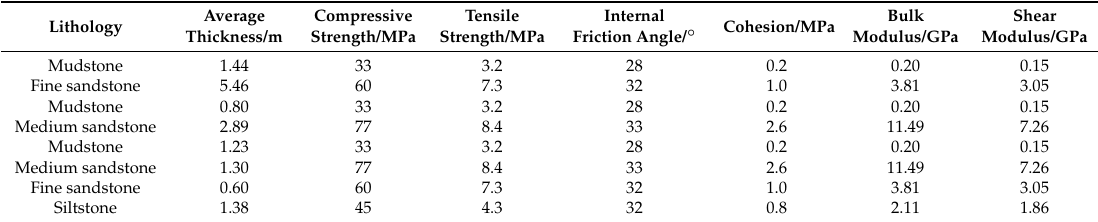
Table 1. Parameters of the roof